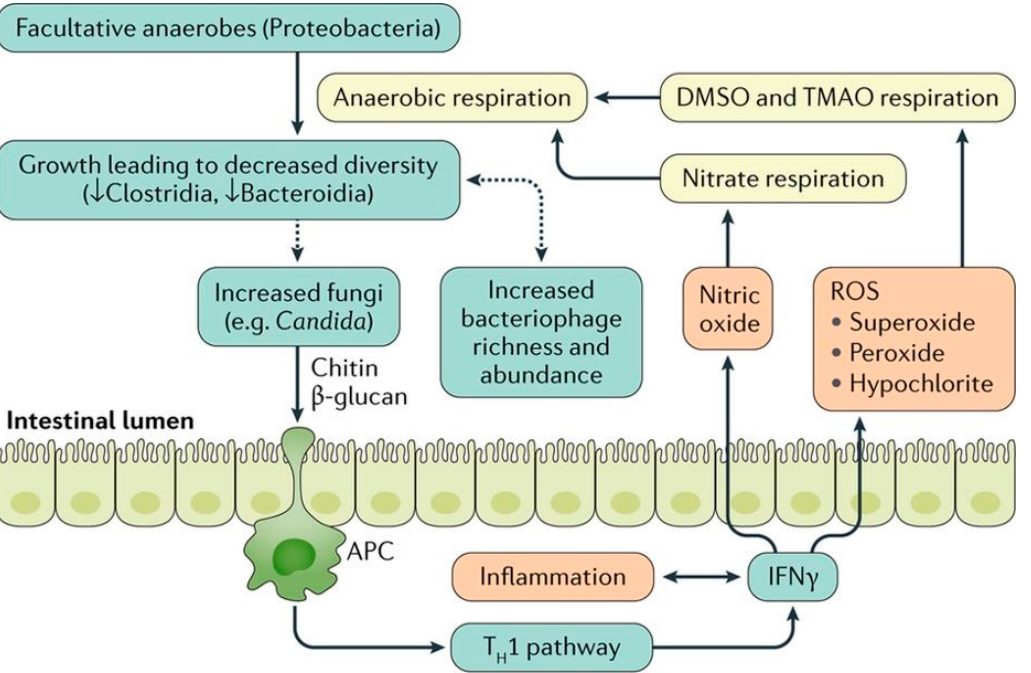
Figure 2. The relationship between gut microbiota and colonic inflammation in inflammatory bowel disease. Inflammation in colon stimulates production of Interferon gamma (IFN- γ ) that eventually generates reactive oxygen species (ROS). ROS make products for anaerobic respiration. These products can be used by facultative anaerobes to outgrow, which leads to decreased bacterial diversity. The dysbiotic microbiota may further stimulate the growth of fungi that can worsen inflammation via chitin and β -glucan antigen-presenting cell (APC) activation of the type 1 T helper (T H 1) pathway. In addition, the microbial dysbiosis is associated with increased bacteriophage richness and abundance, which can affect the bacterial microbiota via gene transfer. DMSO, dimethyl sulfoxide; TMAO, trimethylamine N-oxide. [Adapted with permission [13]].